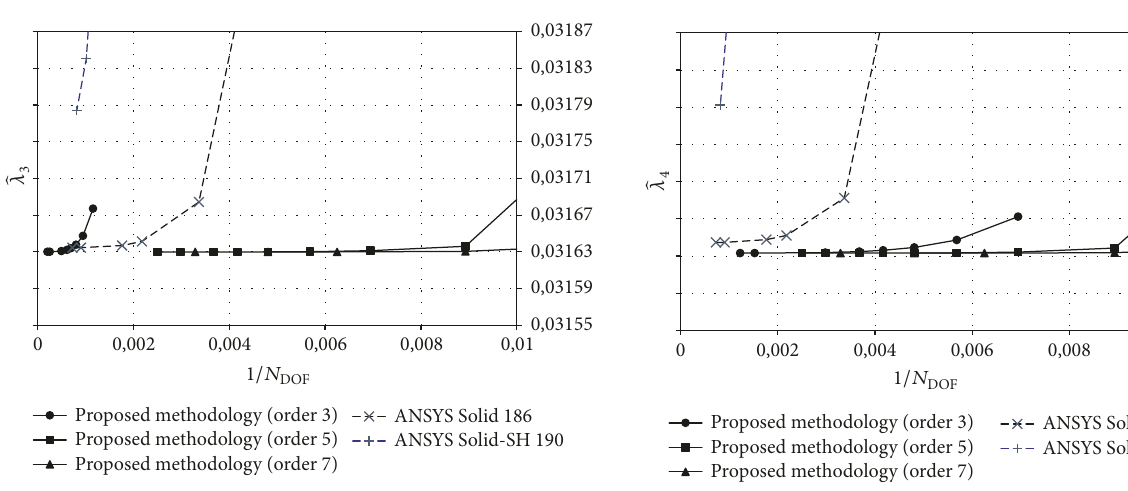
Figure 20: Free beam: